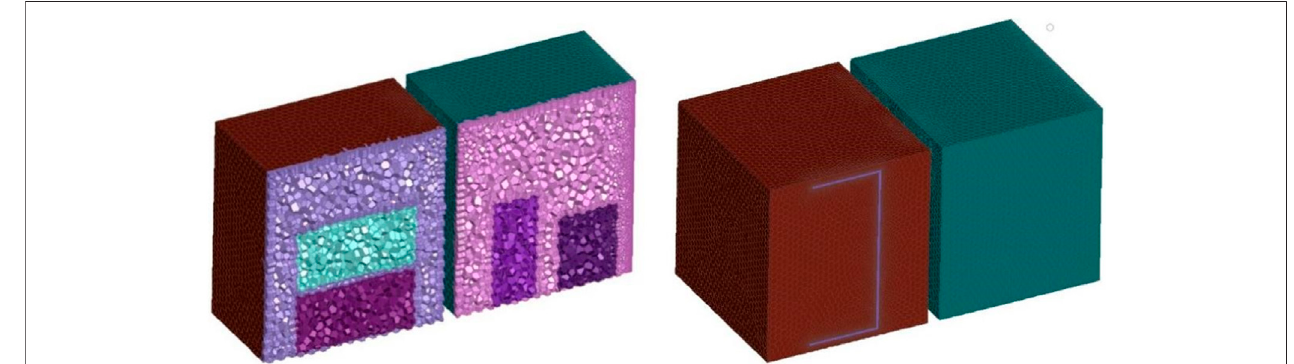
FIGURE 8 | Meshing model.